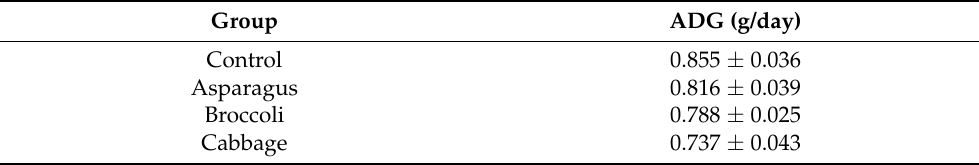
Table 1. The average daily body weight gain (ADG) of mice in different groups.